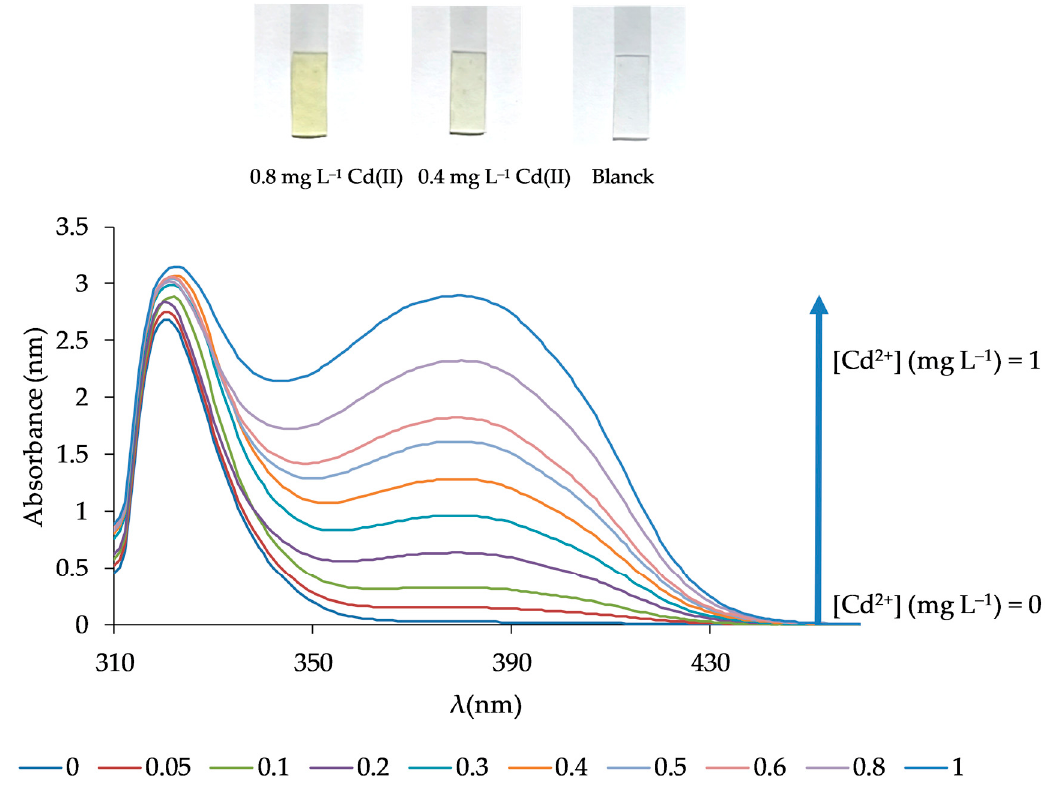
Figure 8. Response spectra of the optical sensor for different Cd(II) concentrations corresponding to the calibration